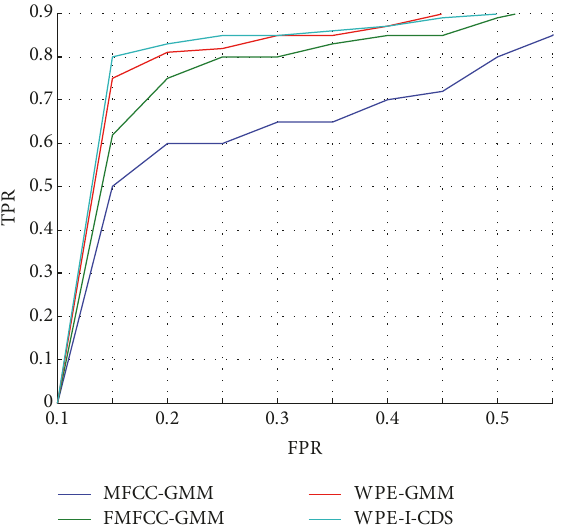
Figure 6: The ROC curves of TPR versus FPR. model to calculate the FPR. The 4 models, such as MFCC- GMM, FMFCC-GMM, WPE-GMM, and our WPE-I-CDS, are used for comparison. To plot the ROC curve, we adjusted the decision thresholds to obtain different ROC points. The ROC curves of those 4 models were shown in Figure